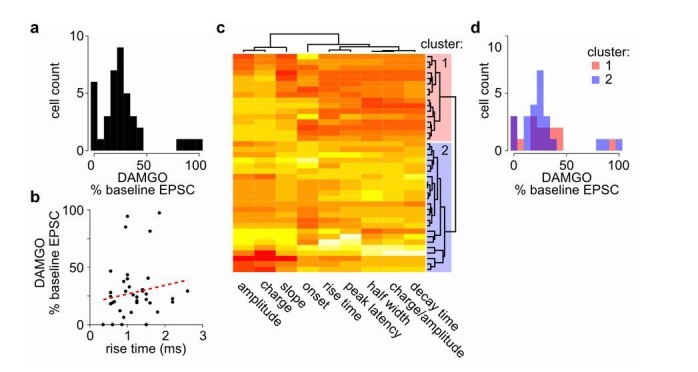
No clear bi-modal or two population effects detected in MOR-mediated suppression of thalamostriatal inputs to the MSNs in the DMS.(a) Histogram of cell distribution based on effects of mu-opioid agonist DAMGO on optically-evoked excitatory postsynaptic current (EPSC) amplitude recorded in the MSNs; n = 40 neurons from 25 mice. The observed DAMGO effects had a non-normal distribution (Shapiro-Wilk normality test, W = 0.8219, p < 0.001), but showed no clear bi-modal distribution of two roughly equal populations. (b) Plot of the DAMGO effects on baseline oEPSC amplitude recorded from MSNs as a function of risetime of the baseline EPSC. There was no correlation between EPSC risetime and degree of EPSC inhibition by DAMGO. Linear regression model (red dash line), R2 = 0.018, F (1, 38) = 0.677, p = 0.416. (c-d) In case two populations exist within the recorded MSNs, we wanted to test whether the effect of DAMGO on baseline EPSC amplitude was significantly different in the two populations defined based on baseline EPSC parameters. (c) Agglomerative hierarchical cluster analysis based on Pearson correlation between baseline EPSC parameters (columns), and Euclidean distance between recorded MSNs (rows), with heatmap representing centered/standardized values (x-x-σ). Two main clusters were defined (cluster 1: red n = 16 neurons/11 mice, cluster 2: blue n = 23 neurons/17 mice) based on baseline EPSC parameters, representing putative subpopulations among the recorded MSNs. (d) Histograms of cell distributions based on DAMGO effects on baseline recorded from the MSNs defined in cluster 1 or 2, red or blue, respectively. Mann-Whitney U test, U = 204, p = 0.751.